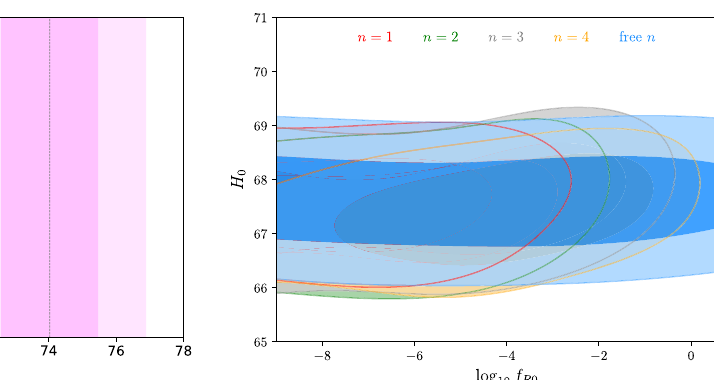
(blue), respectively. The grey dashed line and magenta bands denote H